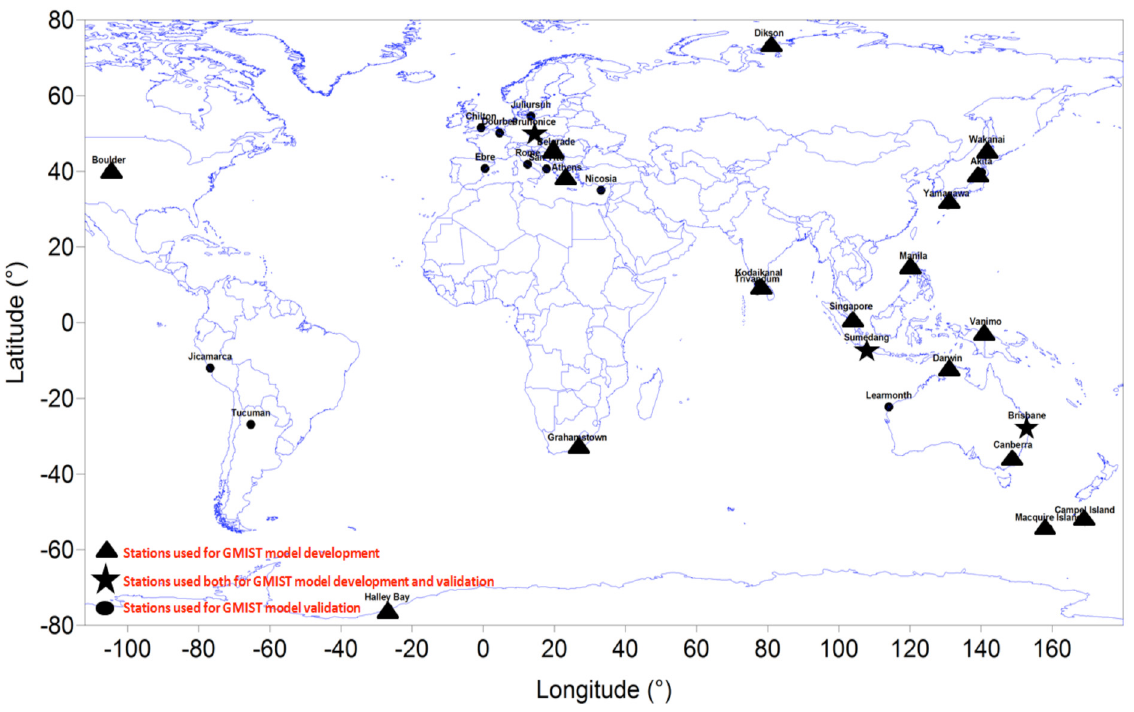
Figure 2. Map of ionospheric stations used for GMIST development and evaluation.